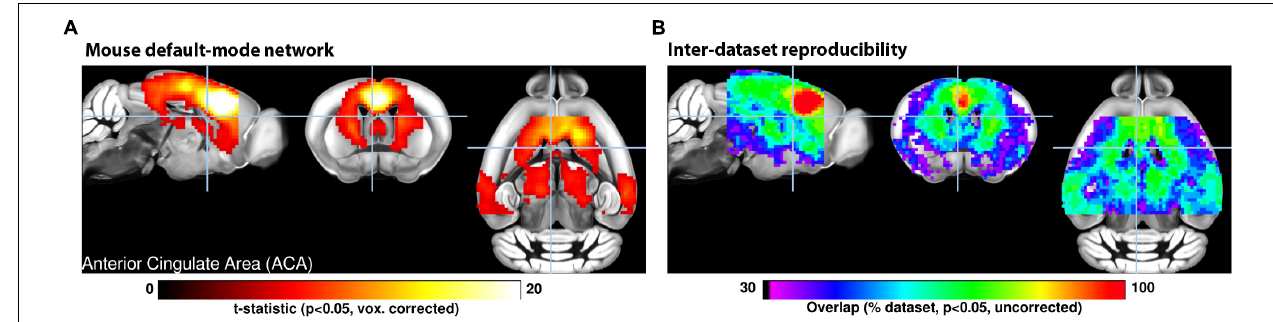
FIGURE 1 | (A) A seed-based analysis of the anterior cingulate area in 98 resting-state fMRI scans reveals the topological distribution of the mouse default-mode network. The regions co-activating with the seed include the dorsal striatum, dorsal thalamus, retrosplenial, and posterior parietal areas. (B) The reproducibility of the default-mode network was assessed in 17 independent datasets consisting of 15 scans each. Overlapping one-sample t -test maps are summarized in a color-coded overlay. 12/17 datasets present converging topological features, the remaining five failed to present evidence of distal connectivity relative to the seed. Adapted with permission from Grandjean et al.